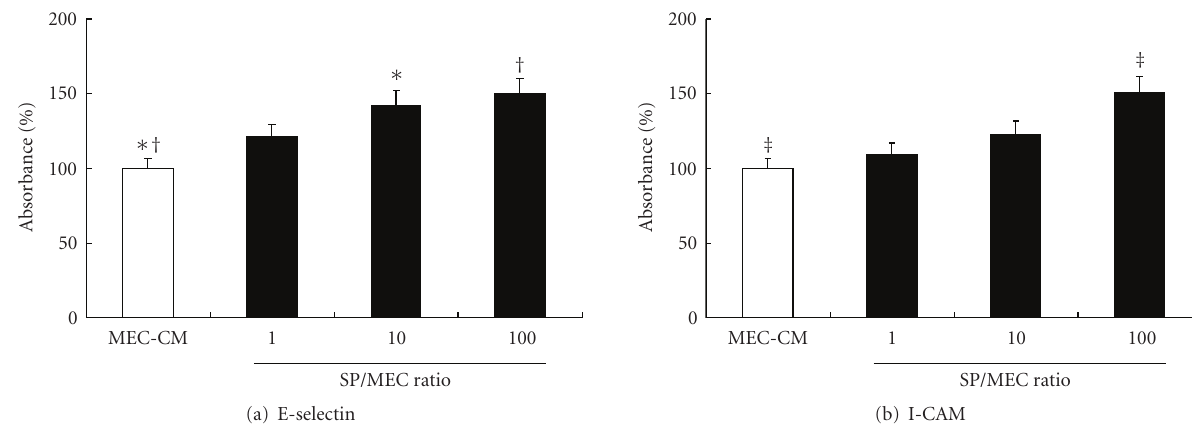
Figure 5: ELIZA for endothelial adhesion molecules (E-selectin and ICAM-1) with alteration of SP/MEC ratio. The endothelial expressions of E-selectin and ICAM-1 were increased in an SP number-dependent manner. The expression of E-selectin was significantly increased in the 10 and 100 SP/MEC-CM and ICAM-1 in the 100 SP/MEC-CM. ∗ P < . 05, † , ‡ P < . 01.